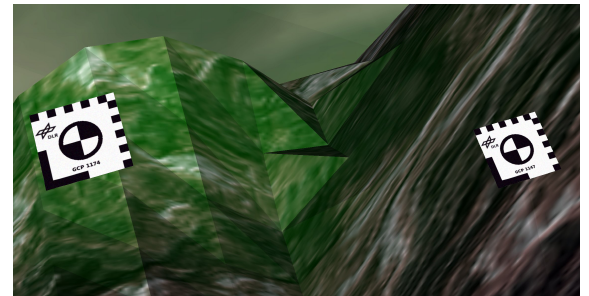
Figure 3. Randomly placed GCP markers